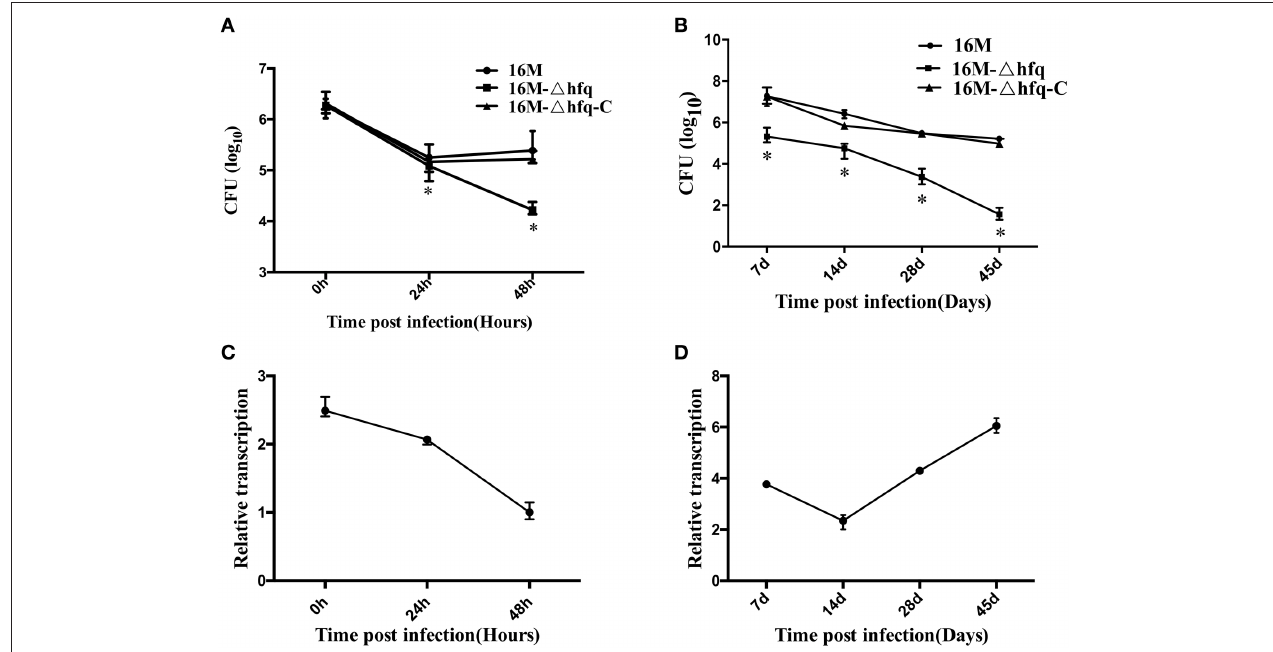
FIGURE 1 | Expression of hfq during macrophage and mouse infection. RAW264.7 cells were infected with 16M, 16M △ hfq, and 16M △ hfq-C, at 0, 24, and 48h post-infection, surviving bacteria number was determined (A) . BALB/c mice were infected with 16M, 16M △ hfq, and 16M △ hfq-C, at 7, 14, 28, and 45 days post-infection, surviving bacteria number was determined (B) . The relative transcription level of hfq during RAW264.7 (C) and BALB/c mice (D) infection was determined by RT-PCR. The SD is indicated by the error bar. Significant differences between the mutant and parent strain were indicated as follows: * P < 0.001